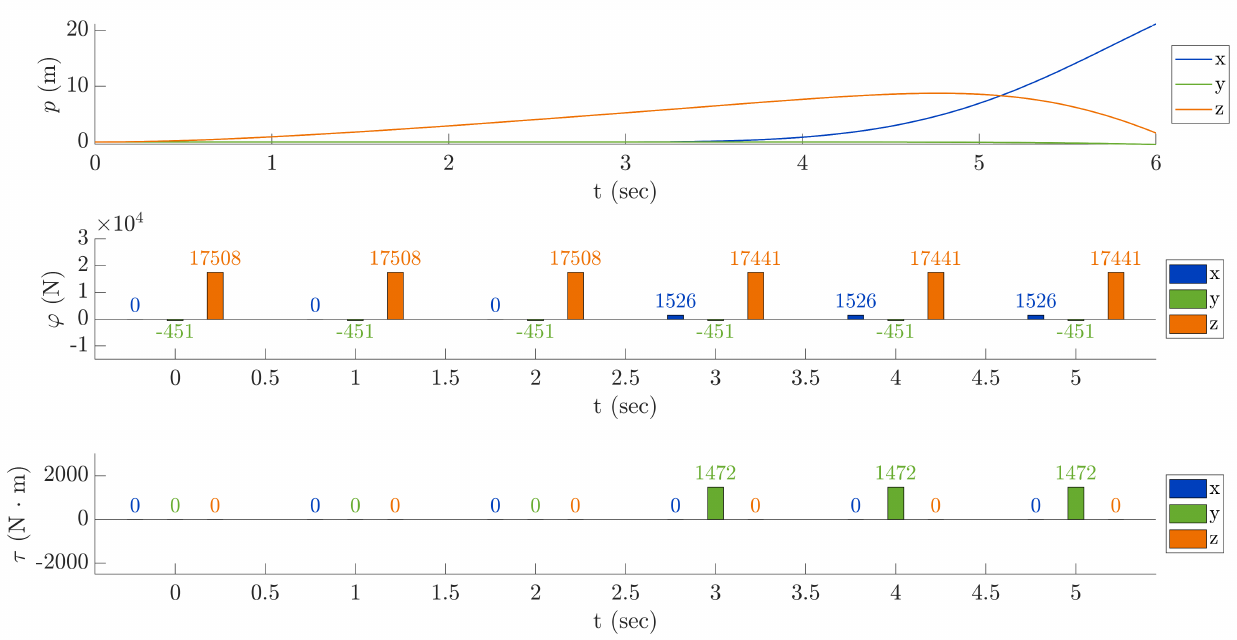
Figure 14. Fourth test—pitch